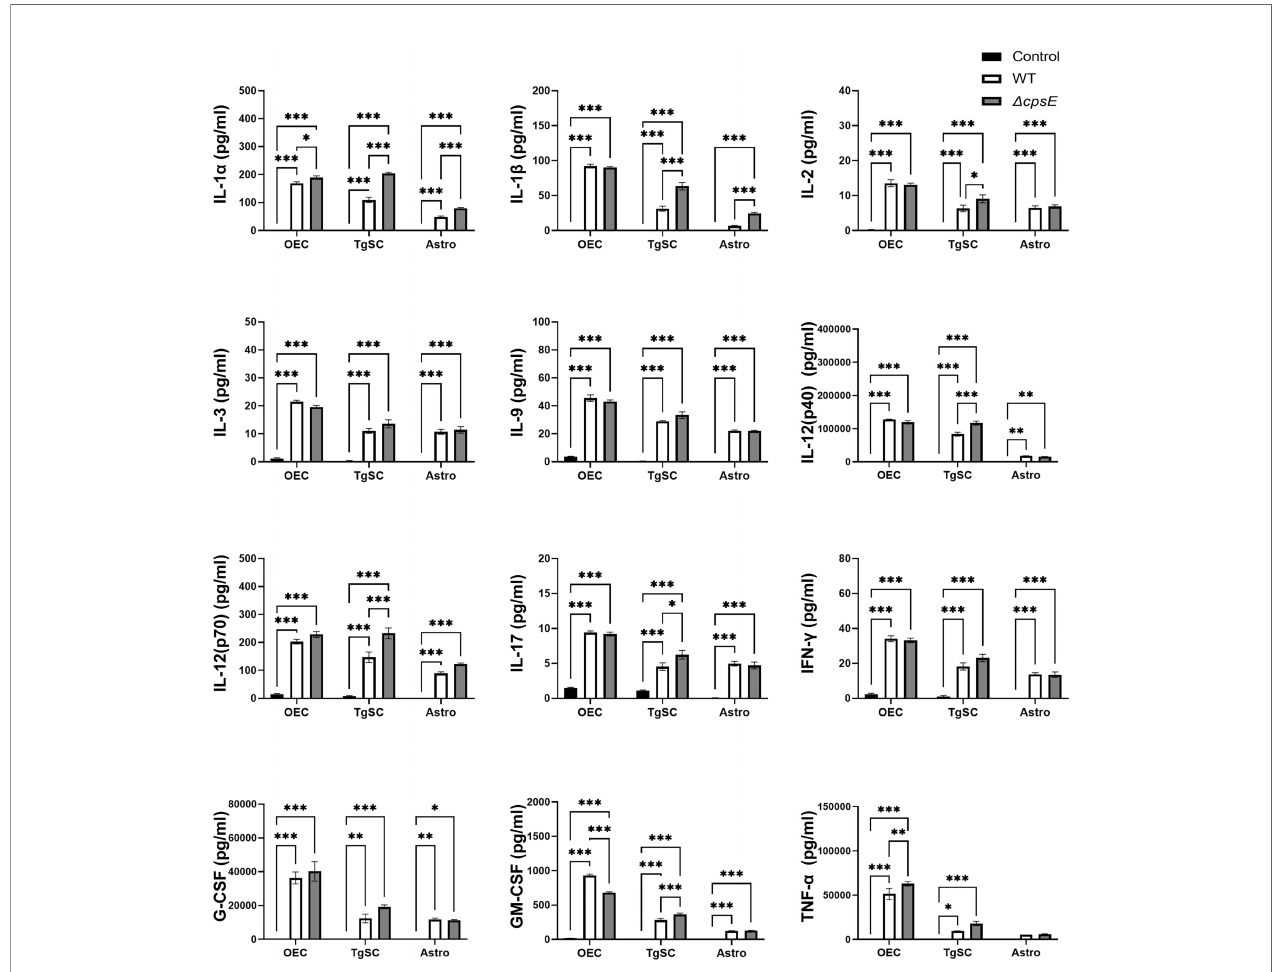
FIGURE 8 | Pro-in fl ammatory cytokine responses in glia after inoculation with wild-type and capsule-de fi cient S. agalactiae . OECs, TgSCs and astrocytes were inoculated with either WT or D cpsE (MOI 100:1) after which the cytokine levels in the medium were analysed at 24 h post inoculation. Data show mean ± SEM, *p ≤ 0.05, **p ≤ 0.01, ***p ≤ 0.001 (two-way ANOVA with Tukey ’ s multiple comparison test, n = 3 technical replicates x 100,000